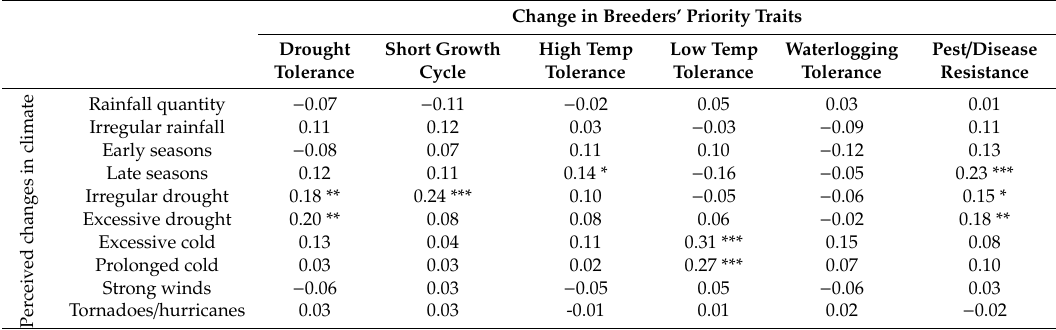
Table 2. Correlation between the change in importance of traits in breeding and perceived changes in climate. Change in Breeders’ Priority Traits Drought Short Growth High Temp Low Temp Waterlogging Tolerance Cycle Tolerance Tolerance Tolerance Rainfall quantity − 0.07 − 0.11